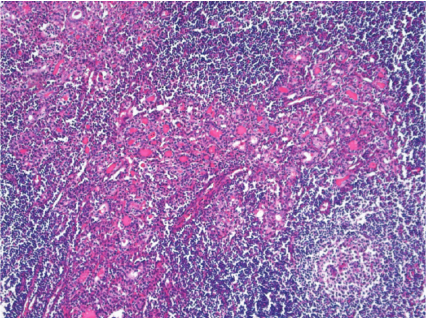
Figure 3: Severe lymphocytic infiltration with formation of lym- phatic follicles and H¨urthle cells (Hematoxylin-eosin, × 100).